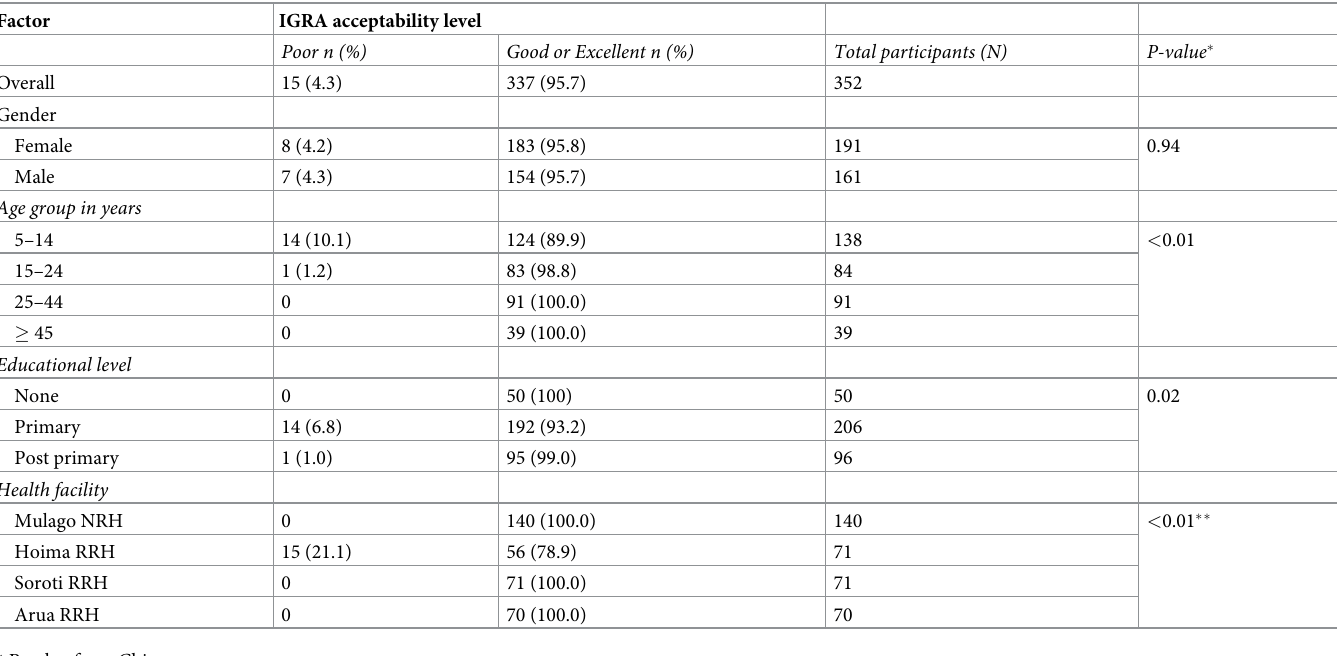
Table 2. Acceptability of IGRA